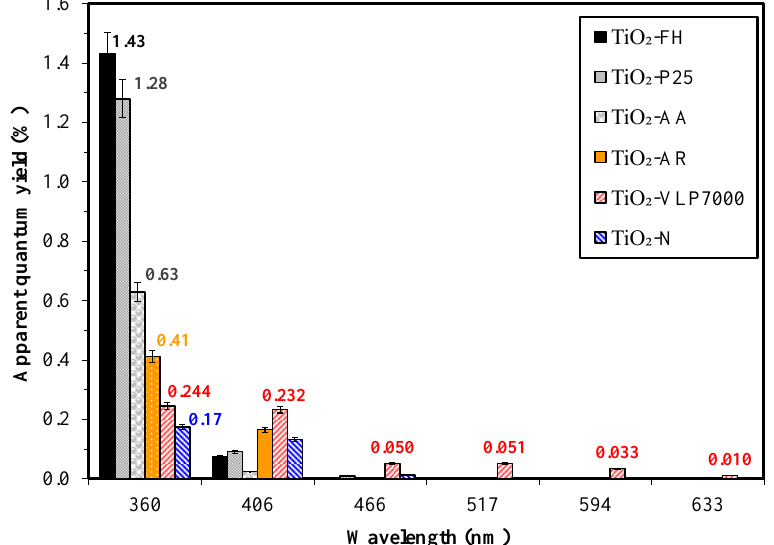
Figure 3. Apparent quantum yields for photocatalytic phenol degradation (c = 0.1 mM).